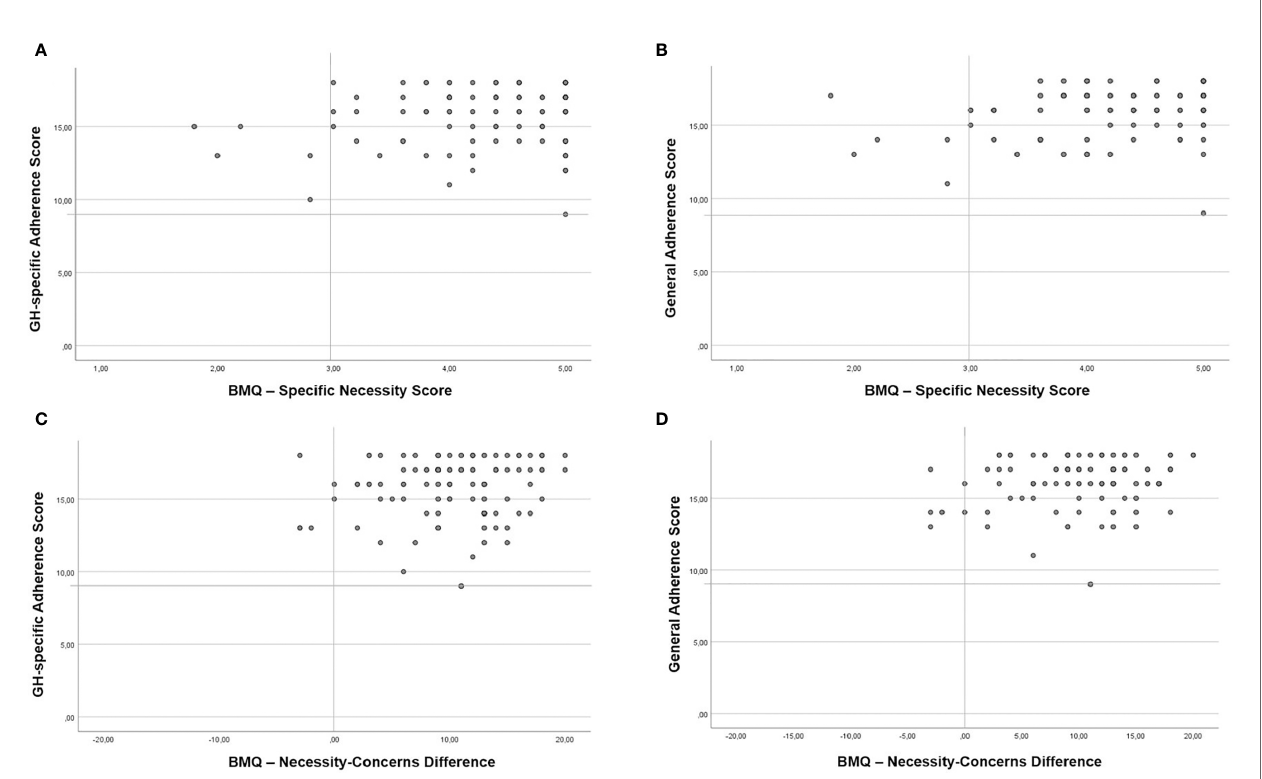
TABLE 1 | Descriptive results of the questionnaires. Adherence General